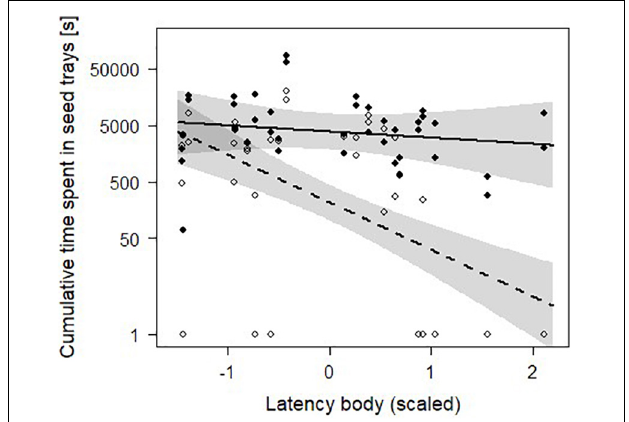
FIGURE 3 | Influence of daytime and latency body (scaled) on the cumulative time animals spent in seed trays on each side of the experimental arena of 21 bank voles. Black dots and the solid line show the raw nighttime data and the prediction line from the linear mixed effects model, respectively. White dots and the dashed line show the raw daytime data and the prediction line from the model. Gray areas represent 95%-confidence intervals. The y -axis is log scaled. The higher the latency body, the shyer is the